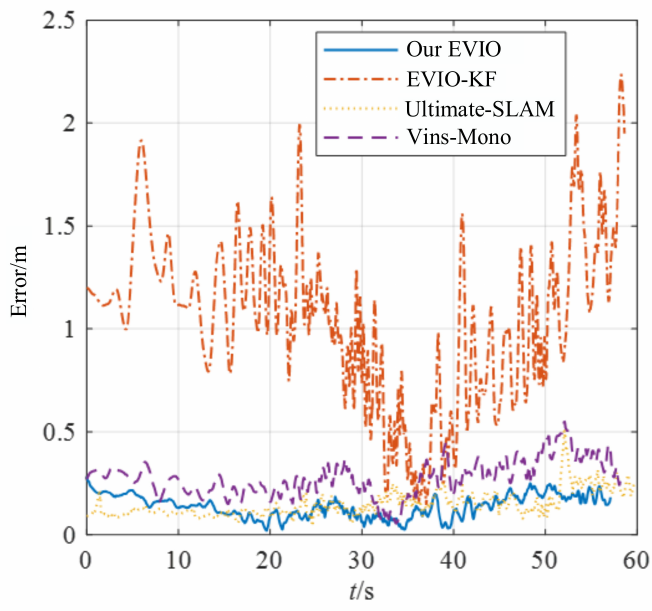
Figure 8. The position error of different algorithms for the